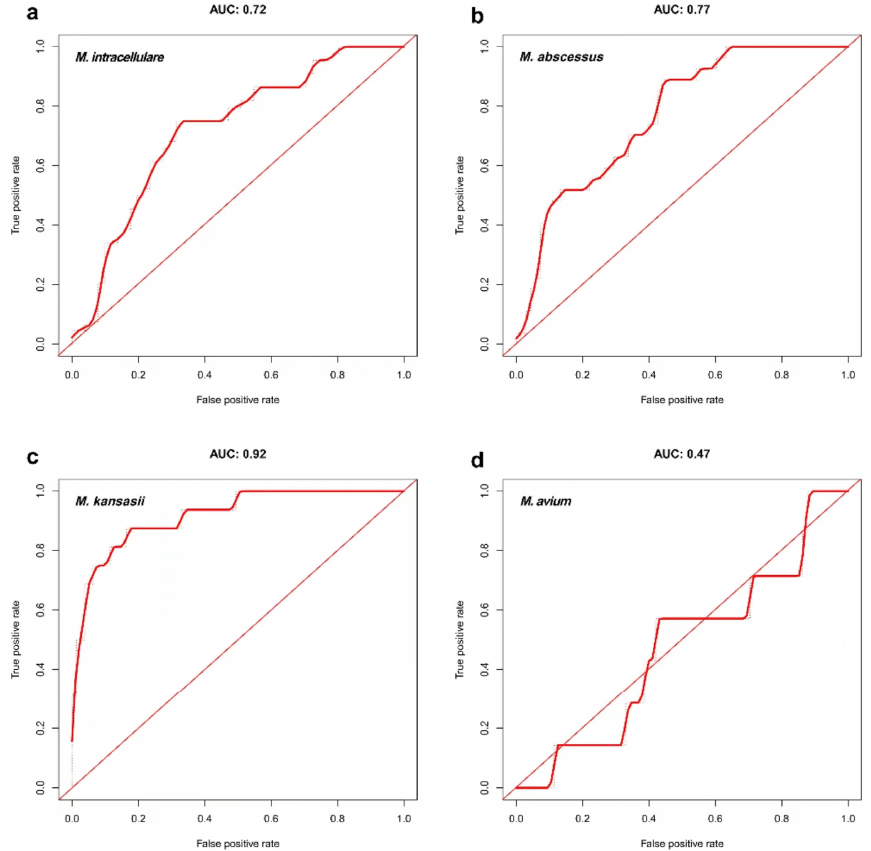
Figure 5. AUC curve of correlation models of mycobacteria in the four groups. ( a ). Duration of cough, positive blood tuberculosis antibody, patchy shadow on imaging, and the number of involved lung fields were taken as joint variables. The strain was identified as M . intracellulare , and the obtained AUC value was 0.72. ( b ). Sex, hemoptysis, previous history of bronchiectasis, positive blood tuberculosis antibody, patchy shadow on imaging, pleural thickening or pleural effusion, cavity, and the number of involved lung fields were taken as joint variables. The strain was identified as M . abscessus , and the obtained AUC value was 0.77. ( c ). Sex, age, emaciation, previous history of pulmonary tuberculosis, positive T-Spot, cavity on imaging, bronchiectasis, and the number of involved lung fields were taken as joint variables. The strain was identified as M . kansasii , and the obtained AUC value was 0.92. ( d ). Age and previous history of pulmonary tuberculosis were taken as joint variables. The strain was identified as M . avium , and the obtained AUC value was